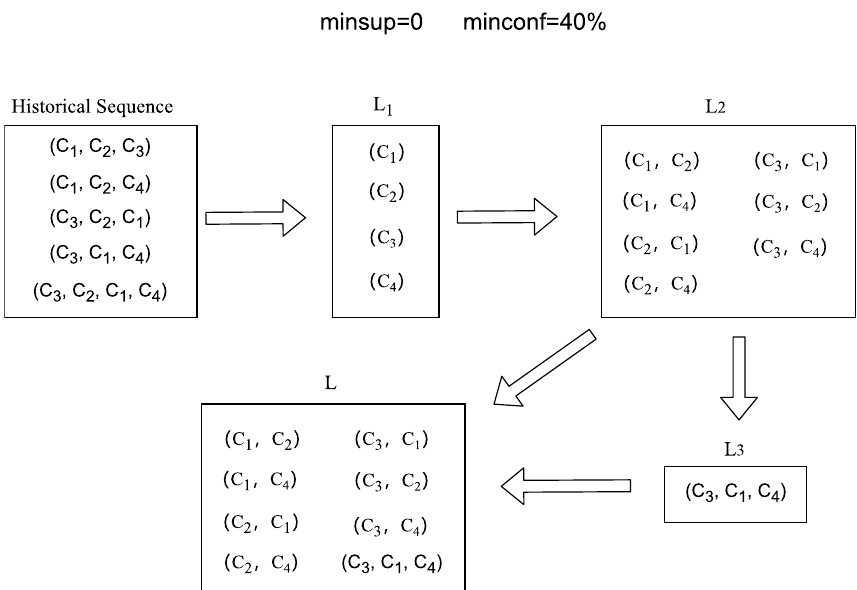
Fig. 3 Association Set mining